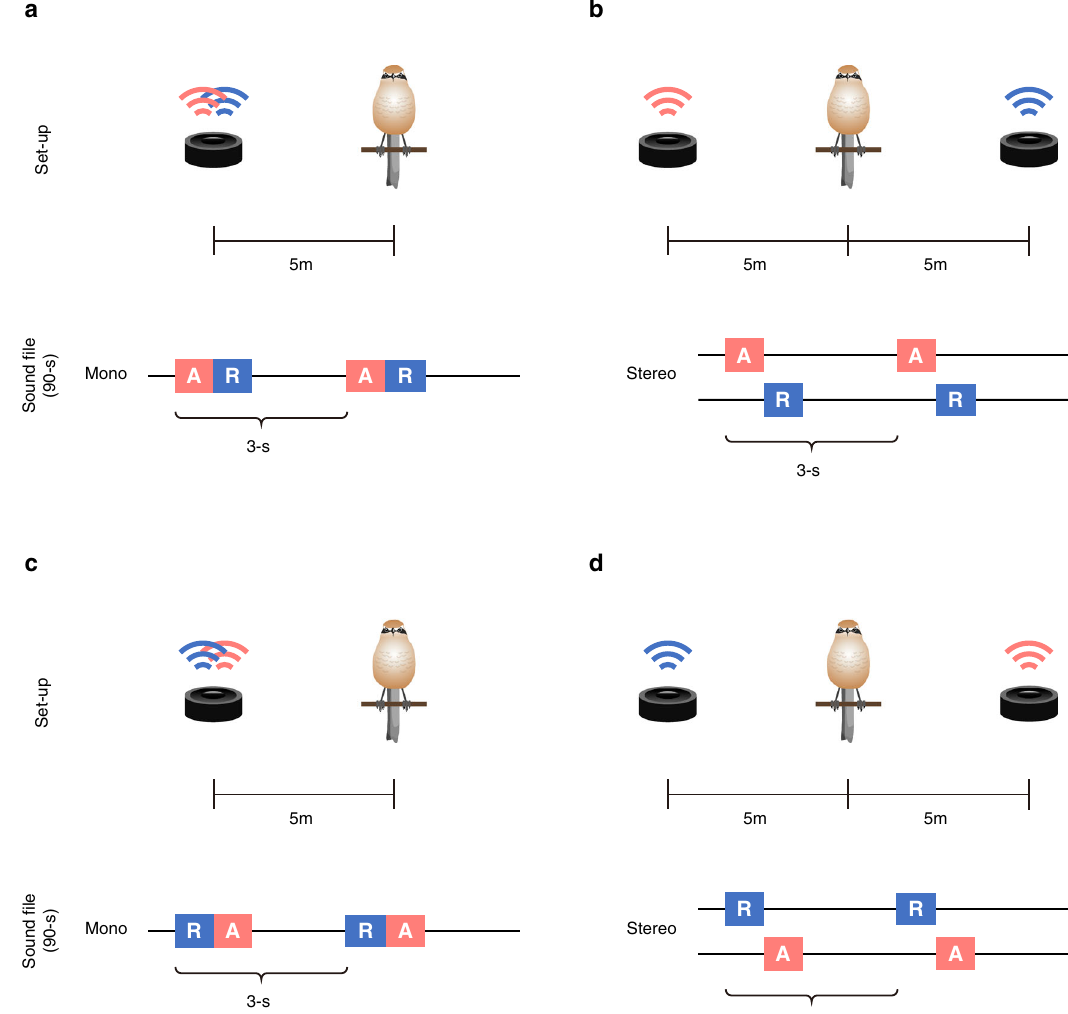
Fig. 3 | Experimental set-up and sound fi les. If an animal uses core-Merge to perceive call sequences, then it should be able to assess whether the component calls are produced from the same spatial location, as well as whether they are temporally linked into naturally ordered sequences. Japanese tits are exposed to a shrikespecimenincombinationwithfourtypesofplaybackstimuli: a alertcallsand recruitment calls are broadcast from one speaker as temporally linked, alert-